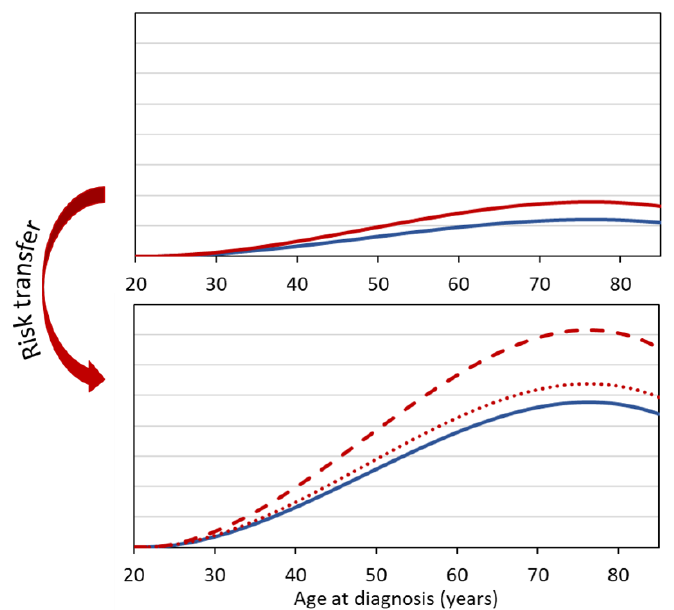
Figure 1. Risk transfer from an exposed population with low baseline rates (blue line in upper panel) to a population with high baseline rates (blue line in lower panel). The scaling of the two graphs is the same. In the upper chart, the red line shows the radiation-related increased rate ( err = 1.5, i.e., 50% increase). A risk transfer using the multiplicative model results in the red dashed line, while a risk transfer using the additive model results in the red dotted line.